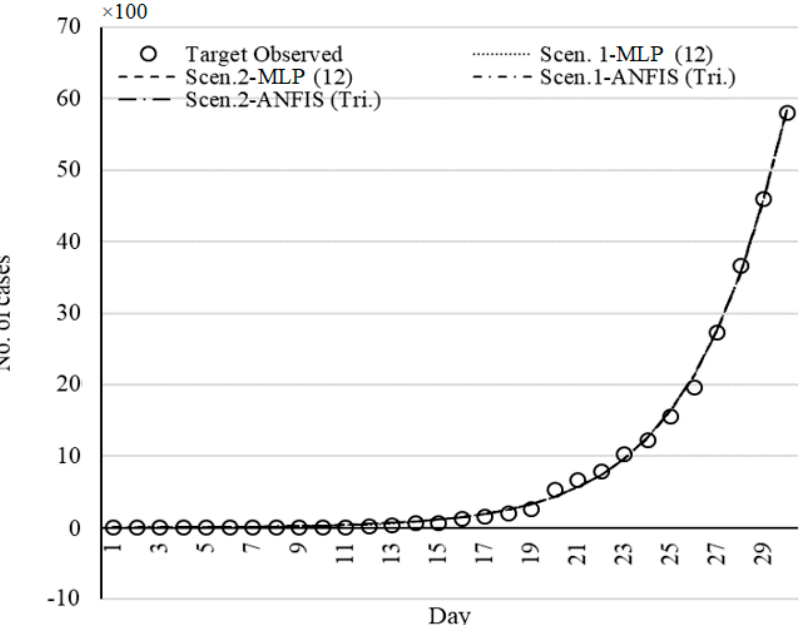
Figure 15. Set of models for Germany fitted by ML methods.